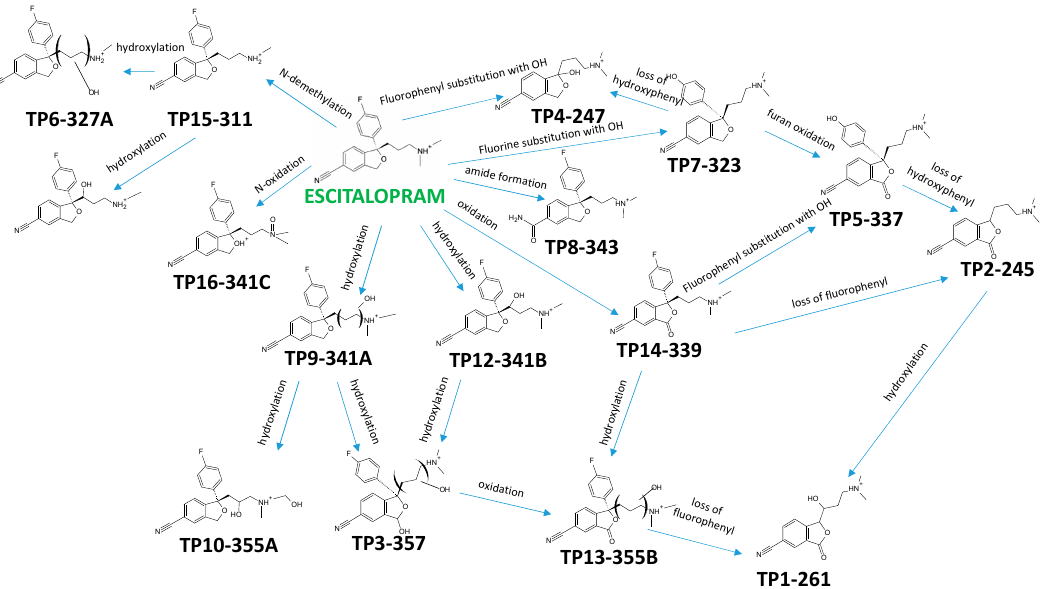
Figure 4. Proposed mechanism of reactions involved in the ESC photodegradation. Considering the TPs that have lost the fluorine atom (TP1, TP2, TP4, TP5 and TP7),